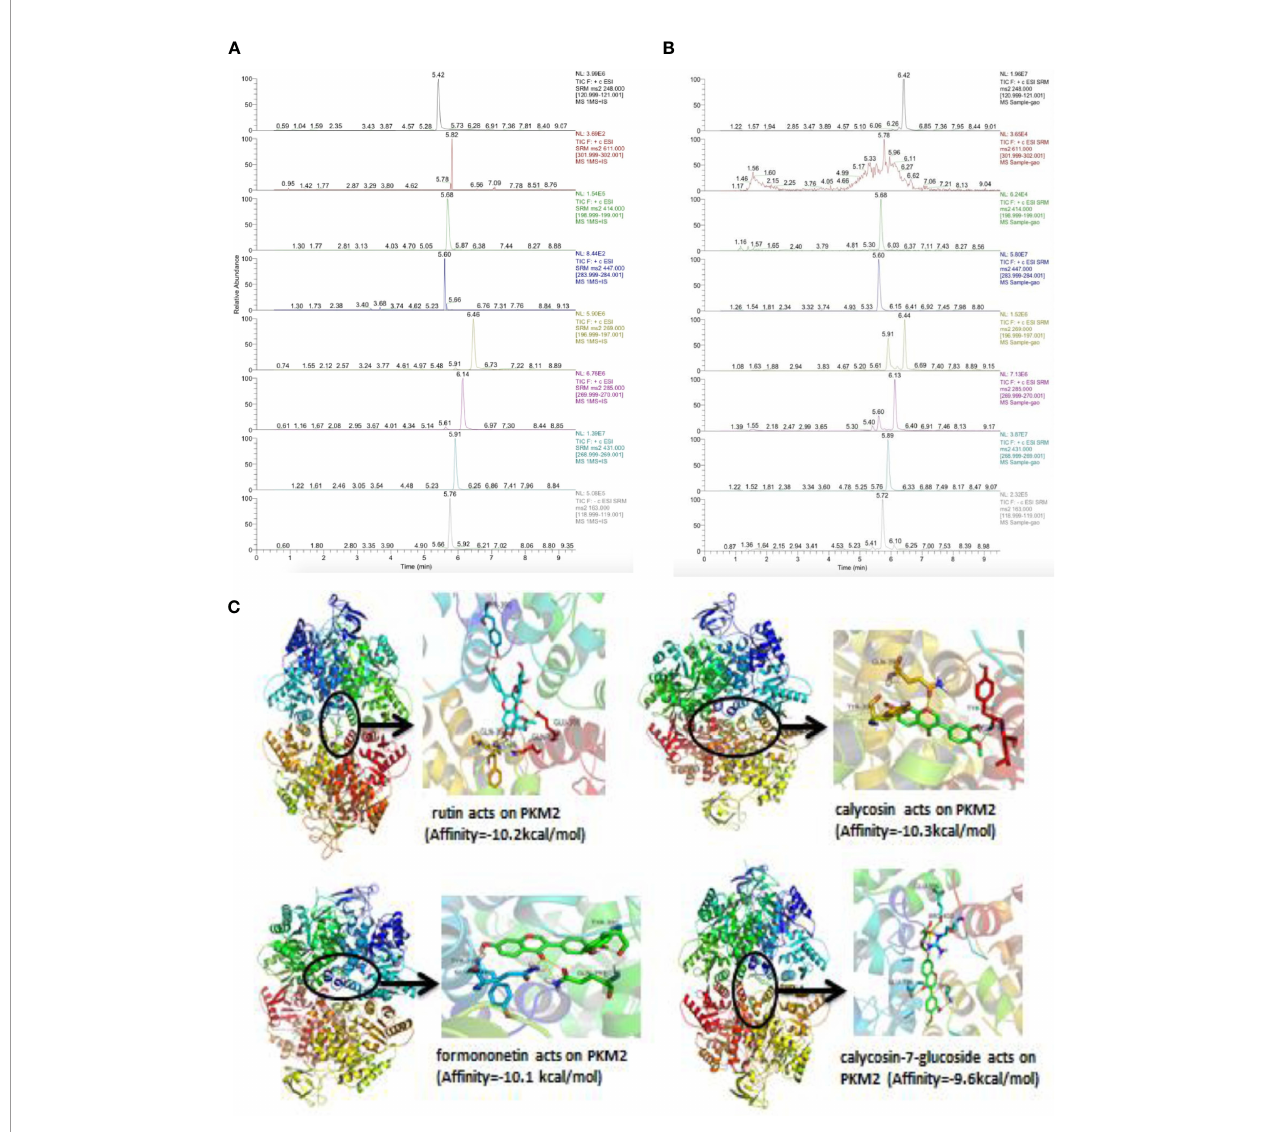
FIGURE 8 | Chemical components in mJPYZ showed strong af fi nity with PKM2. (A, B) The major chemical constituents in mJPYZ and mixture standards were analyzed by LC-ESI-MS/MS analysis. (C) Molecular docking of the binding modes of PKM2 with the major compounds in mJPYZ. The results showed rutin, calycosin, formononetin and calycosin-7-glucoside had strong af fi nity with